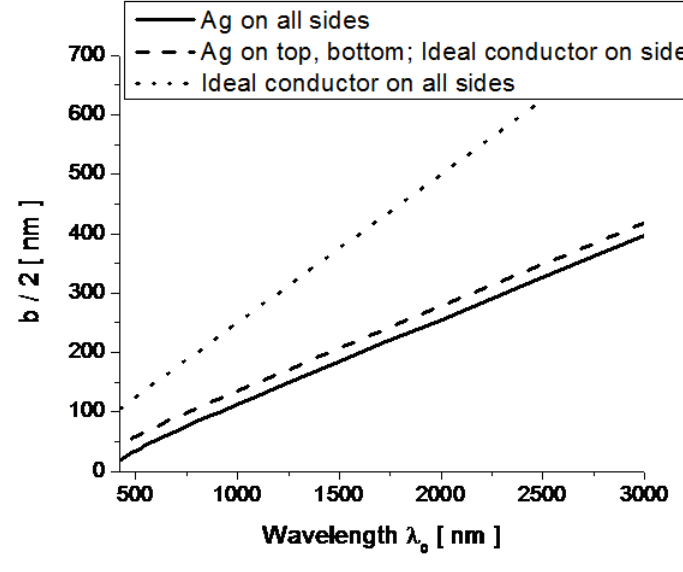
. Figure 2. Cut-off half-width / 2 b versus wavelength for the rectangular plasmonic waveguide of Figure 1 with 20 a nm  . The solid line uses Equation (2), calculated ch assuming that the waveguide has four walls made of silver, the dashed line is calculated assuming that the lateral walls are perfect conductors, the dotted line refers to a perfectly conducting rectangular